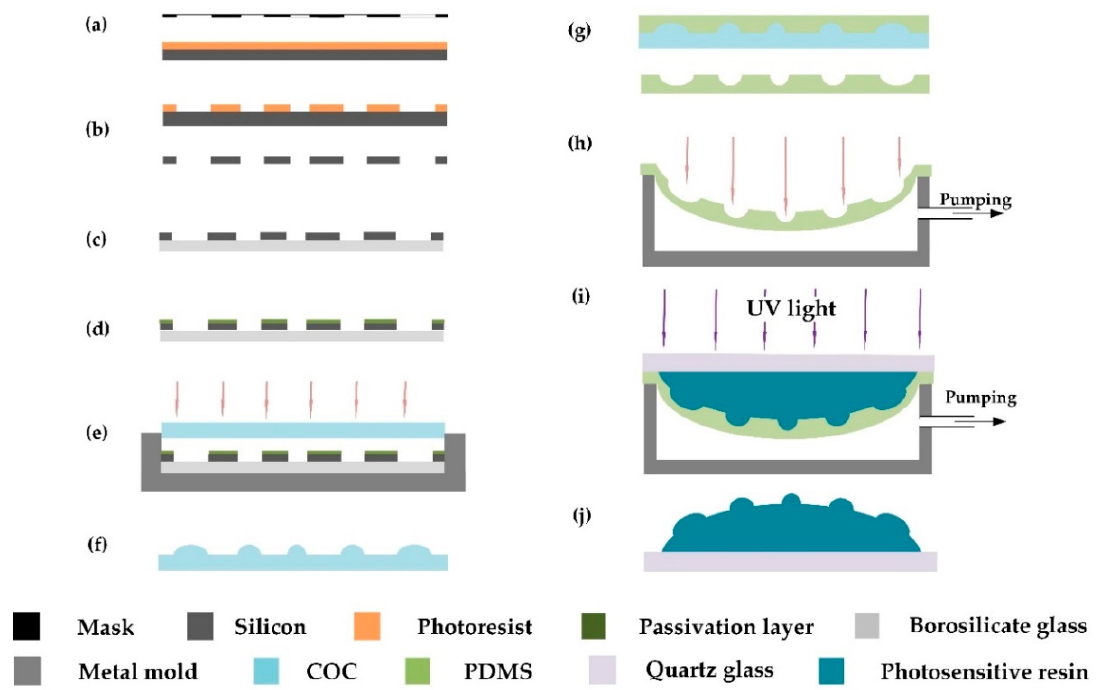
Figure 2. Schematic of manufacturing curved compound eyes: ( a ) AZ5214 photoresist spin-coated on silicon substrate and exposed; ( b ) developed and etched of silicon wafers; ( c ) patterned silicon substrate bonded to borosilicate glass; ( d ) passivation layer grown on the surface; ( e ) polymer heated and pressed; ( f ) polymer peeled off to get microlens array (MLA) pattern; ( g ) structure replicated on polymer with polydimethylsiloxane (PDMS); ( h ) PDMS membrane deformed and packaged in a sealed cavity under pressure difference; ( i ) photosensitive adhesive poured and cured; ( j ) curved compound eyes peeled off.